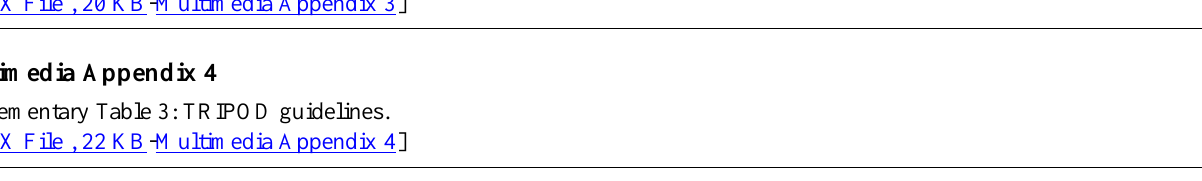
Supplementary Table 2: Brier scores for each model and calibration type.